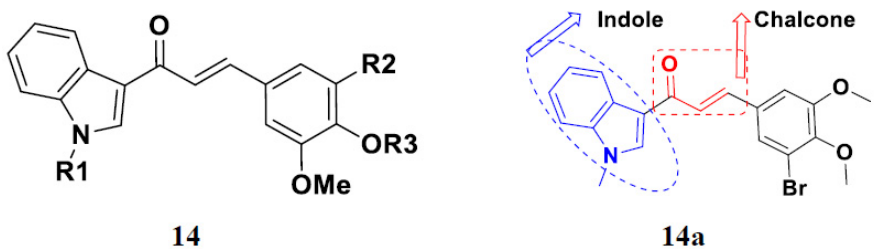
Figure 16. Structure of indole-chalcone based hybrids and the most promising compound 14a. Table 14. In vitro cytotoxic activities of indole ‐ chalcone based hybrid compounds 14 ( b – e ). Compound